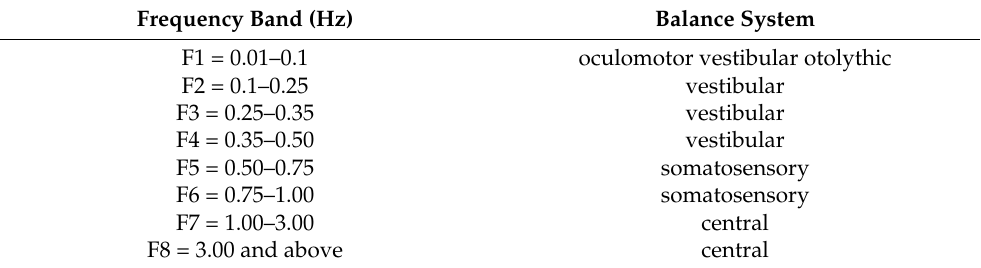
Table 2. Frequency bands of the Tetrax system and the corresponding balance mechanism in- volved